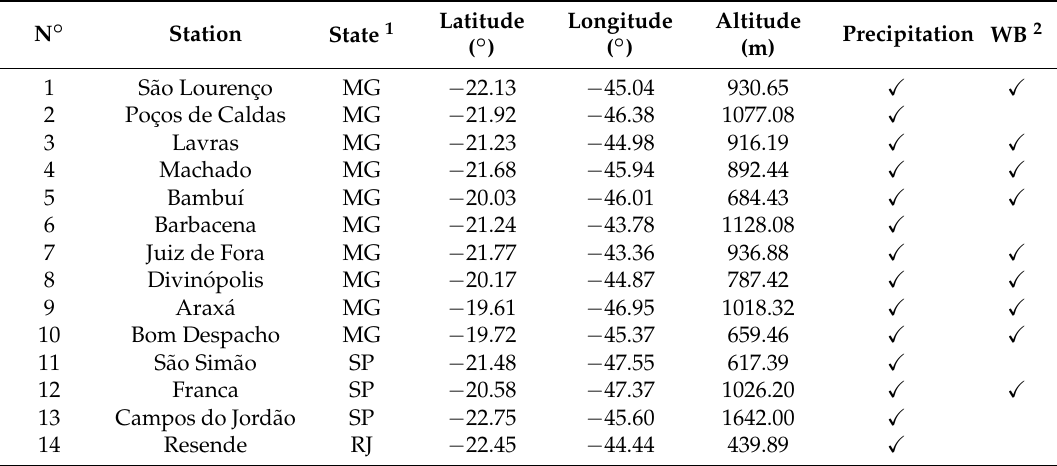
Table 1. Location of the meteorological stations. Availability of data is indicated by ( (cid:88)